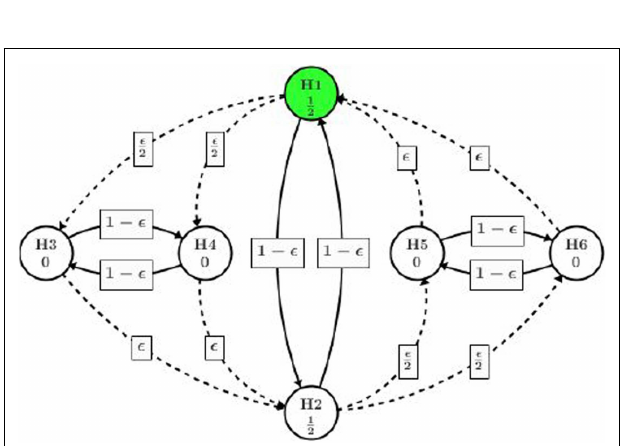
FIGURE 4 | Infinitesimal small weight edge at H 3 (H 4 )TO H 2 .